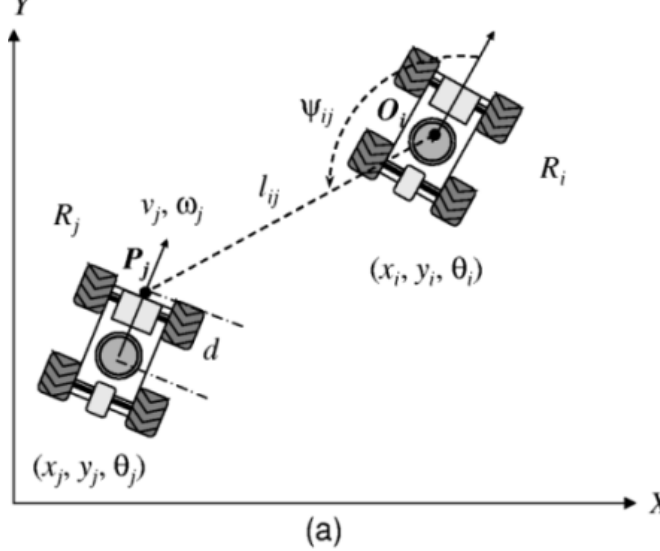
Figure 5. Two robots using basic leader-following controller (Source: